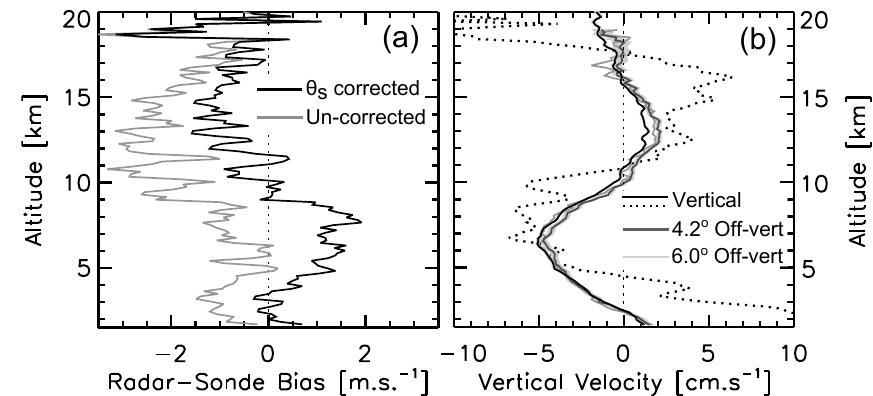
Figure 3. (a) As Fig. 1b but showing radar–radiosonde wind speed bias corrected for aspect sensitivity (black line) and un-corrected (grey line). Error shading has not been included to aid interpretation; the standard error for both curves is as Fig. 1b. (b) Dotted line: vertical velocities from the vertical beam averaged over the radar–radiosonde comparison period. The standard error (not shown) is the width of the solid lines. Solid lines: vertical velocities averaged over the 8 weeks of special operation, from vertical, and complementary off-vertical (4.2 and 6 ◦ degree zenith), beams. Shading shows the standard error for the vertical and 4.2 ◦ beams. To aid interpretation, the error for the 6 ◦ beam is omitted, but it is comparable to that of the 4.2 ◦ beam.